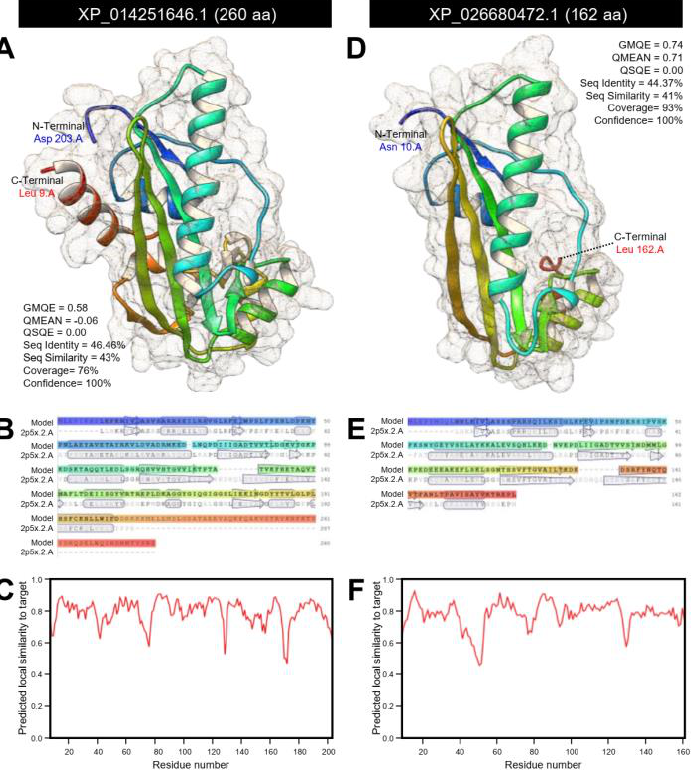
Figure 12. The crystallographic three-dimensional (3D) modeling of N -acetylserotonin O-methyltransferase ( DcASMT ) of Diaphorina citri . ( A , D ) The predicted three-dimensional (3D) structure model and its associated mesh surface of ClASMT (XP_014251646.1) and DcASMT (XP_026680472.1), respectively. The tertiary structures were predicted with 100.0% confidence by the single highest scoring template of the crystal structure of the Maf domain of human N-acetylserotonin O-methyltransferase-like protein (PDB ID: 2p5x.2.A) and refined to 2.00 Å resolution. Protein chains are colored according to the rainbow color spectrum, from blue (N-terminus) to red (C-terminus). ( B , E ) Model–template alignment of ClASMT and DcASMT , respectively. AA sequences of each model were aligned with the template (6k80.1.A). Secondary structures are represented by rectangles ( α -helices) and arrows ( β -sheets). Matched sequences are indicated in black. ( C , F ) Local quality estimate of the predicted models of ClASMT and DcASMT , respectively. All bioinformatics analyses were carried out based on recent available data on the “ Diaphorina citri OGS v2.0 proteins” dataset available on Citrus Greening Solutions website (https://citrusgreening.org/organism/Diaphorina_citri/genome, 12 February 2021) and the most recent available data in GenBank, the national center for biotechnology information website (NCBI, http://www.ncbi.nlm.nih.gov/gene/, 12 February 2021). The 3D structure was created using the SWISS-MODEL server (https://swissmodel.expasy.org/, 12 February 2021) and visualized with the UCSF-Chimera package (version 1.15) (https://www.cgl.ucsf.edu/chimera/, 12 February 2021). GMQE: Global model quality estimation and QSQE: Quaternary structure quality estimate. Additionally, the mRNA hairpins of ClASMT (1091 bp; XM_014396160.1) and DcASMT (746 bp; GenBank Accession no. XM_026824671.1) were predicted using the nucleotide se- quence with strengths of base pairing probabilities of minimum free energy (MFE; Figure